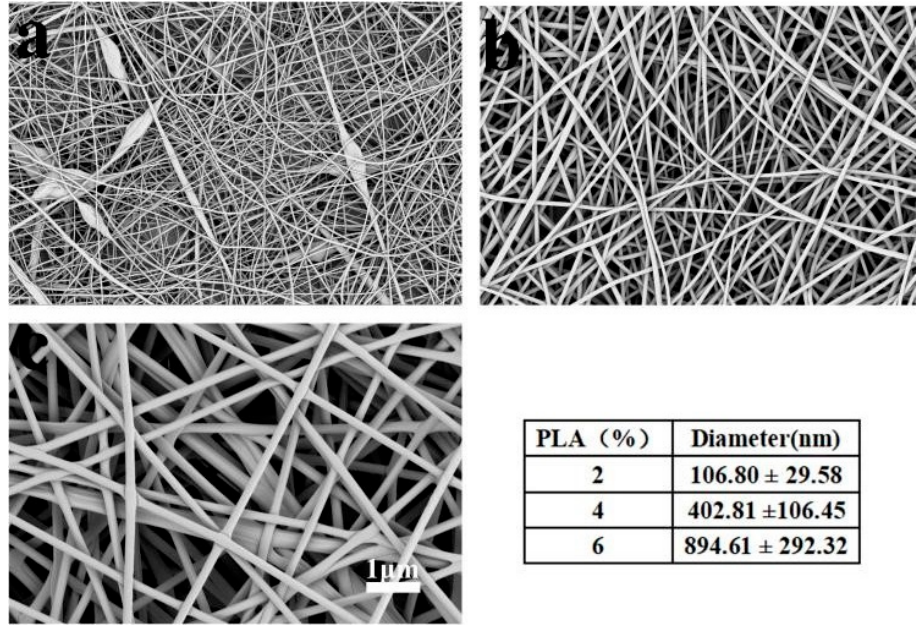
Figure 1. The morphologies and diameters of the poly(lactic acid) (PLA)fiber membranes, ( a ) 2%; ( b ) 4%; and ( c ) 6%.